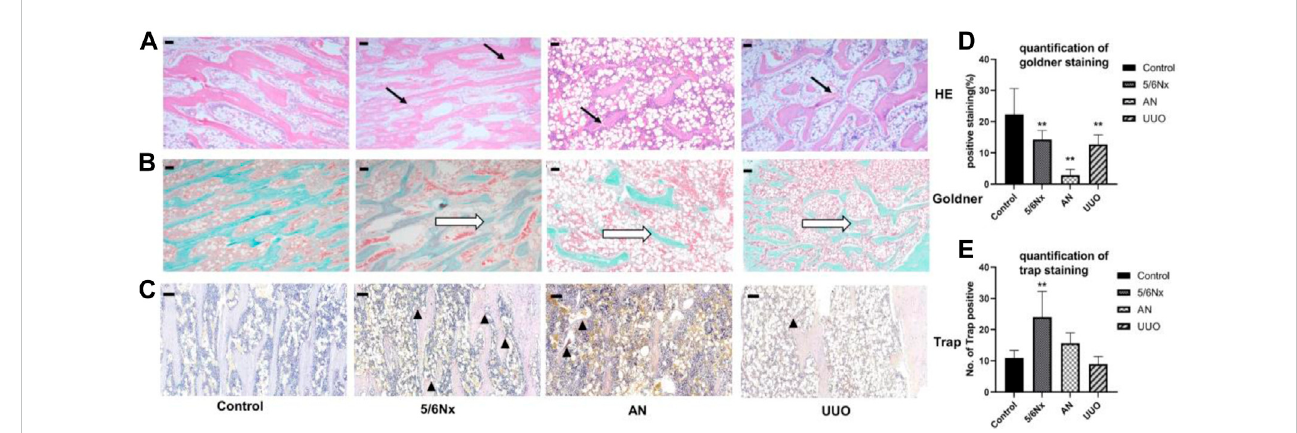
Histopathological analysis of femurs in different models. (A) Representative images of HE staining, × 40, scale bar = 200 μ m. Trabecular bone: black arrows. (B, D) Representative images of Goldner ’ s staining for assessment of newly formed bone areas (expressed as the percentage of the positively stained